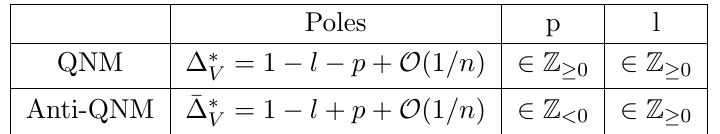
Table 1. Summary: Poles for vector (anti)quasinormal modes in the (cid:1) complex